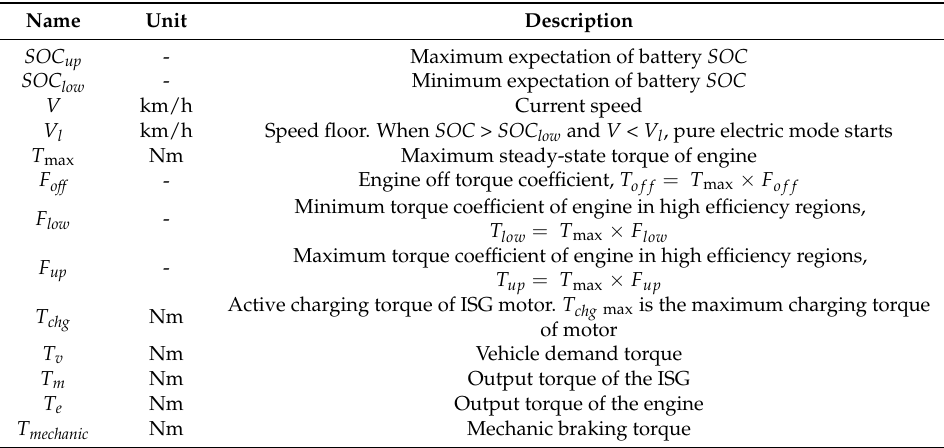
Table 2. Parameters of control